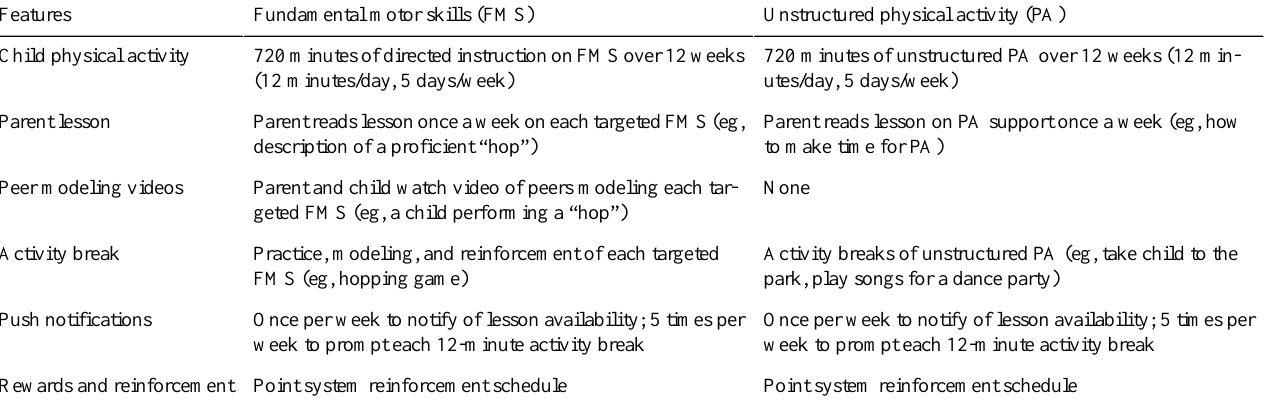
Table 1. PLAY app: features of each condition.